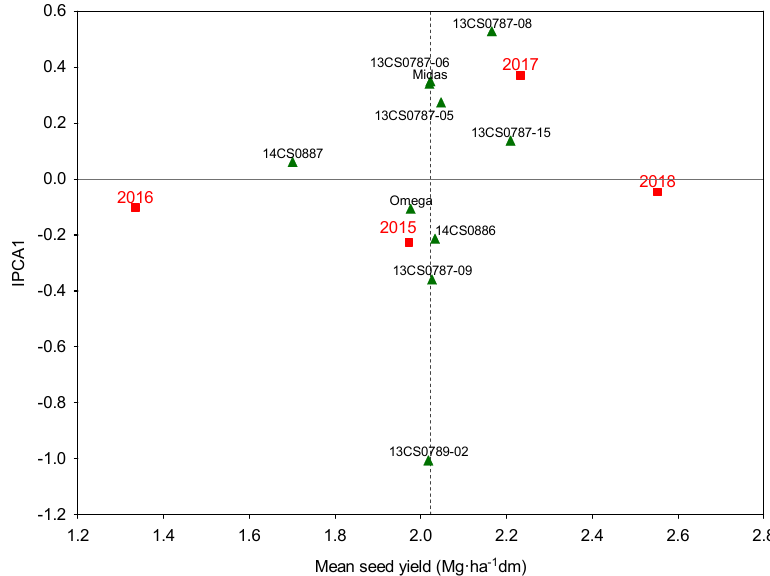
Figure 3. AMMI-1 biplot of the seed yield of 10 camelina genotypes (triangles) across four experimental years (2015–2018) with varied weather conditions (squares). The average straw yield was highest in 2018 and lowest in 2017. The genotype 13CS0787-15 (ASV = 0.41; Shukla = 0.055) was characterized by the highest average straw yield, and genotype 14CS0887 (ASV = 0.57; Shukla = 0.050)—by the significantly lowest straw yield (Figure 4). The scatter of points in the AMMI-1 diagram indicates that many genotypes contributed significantly to the effect of the GE interaction. The greatest contribution was made by genotypes 14CS0886, 13CS0787-06, 13CS0787-08, and cv. Midas.